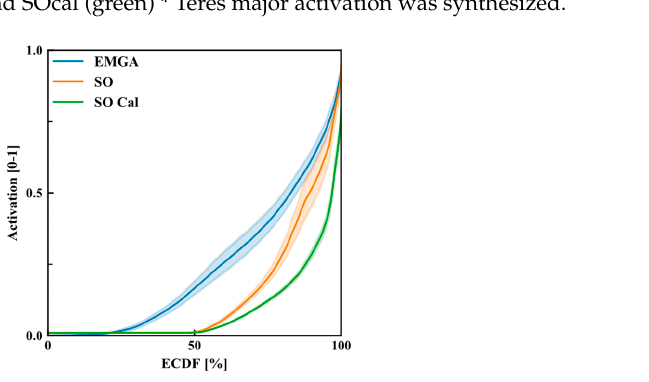
Figure 4. Empirical cumulative distribution of all muscle activations (solid line: mean value, shaded region: 95% confidence interval) predicted by EMGA (blue), SO (orange) and SOcal (green): for a given activation ( a ), the ECDF shows the percentage of data who is at most equal to a .